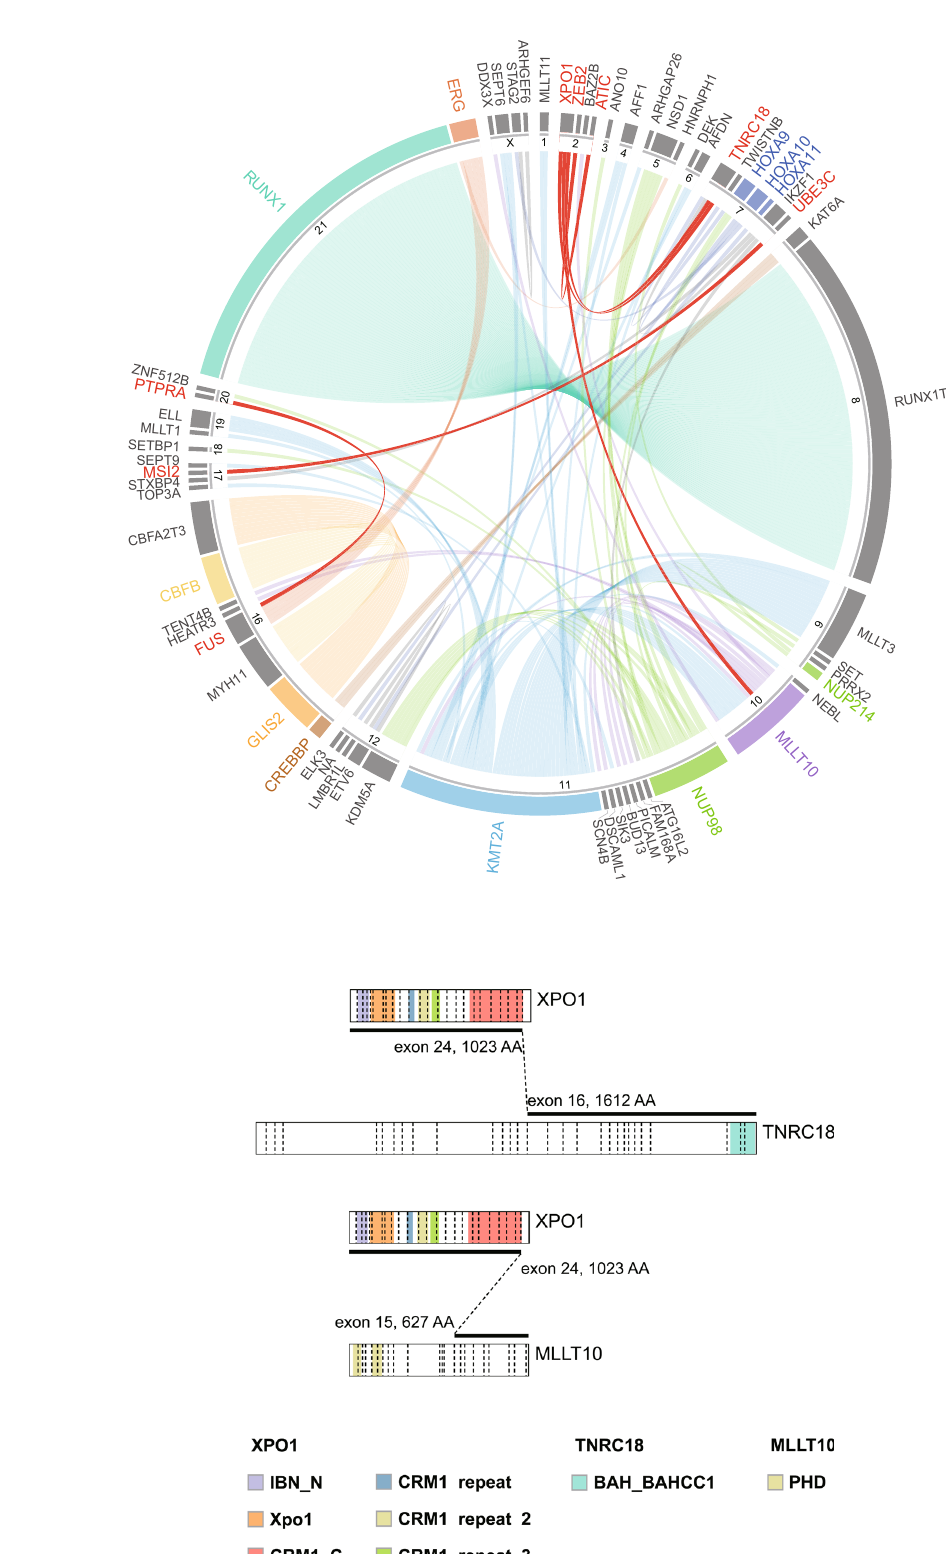
Fig. 1 Gene fusions in Chinese pediatric AML. a Circos plot shows the previously undescribed and recurrent fusions ( n = 206), for which one or both fusion partner genes were detected in ≥ 2 cases. Fusions with multiple partners are grouped and color coded. Fusions that have not been described previously are shown in red. b XPO1 fusions that were detected with RNA-seq, including the in-frame fusion of XPO1-TNRC18 and XPO1-MLLT10